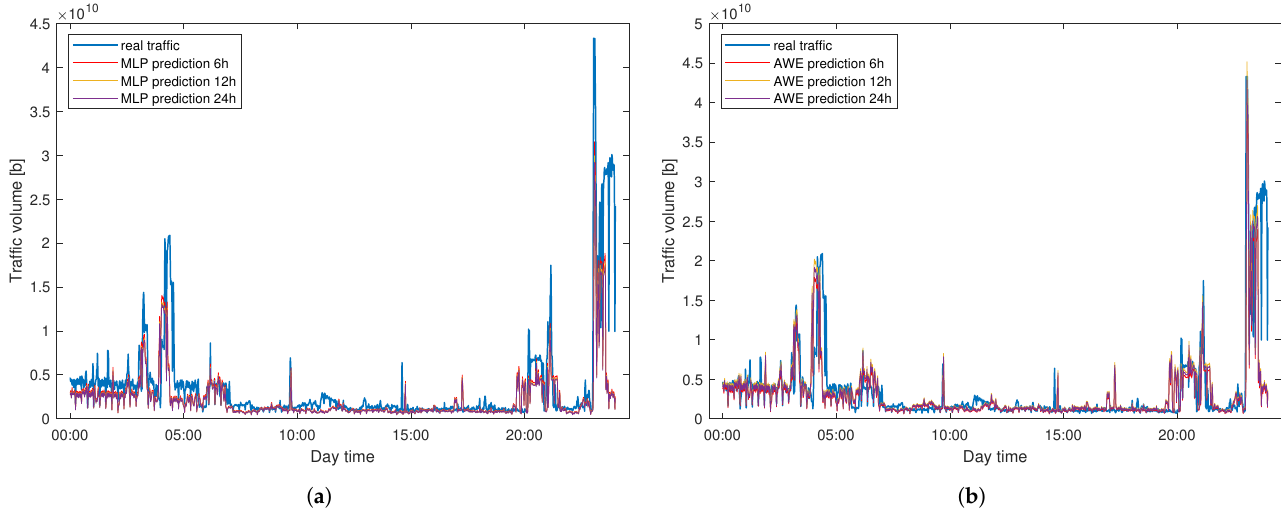
Figure 15. Efficiency of machine learning-based traffic prediction—observed and predicted traffic as a time function for WASK and 21 January 2021. ( a ) MLP method, ( b ) AWE